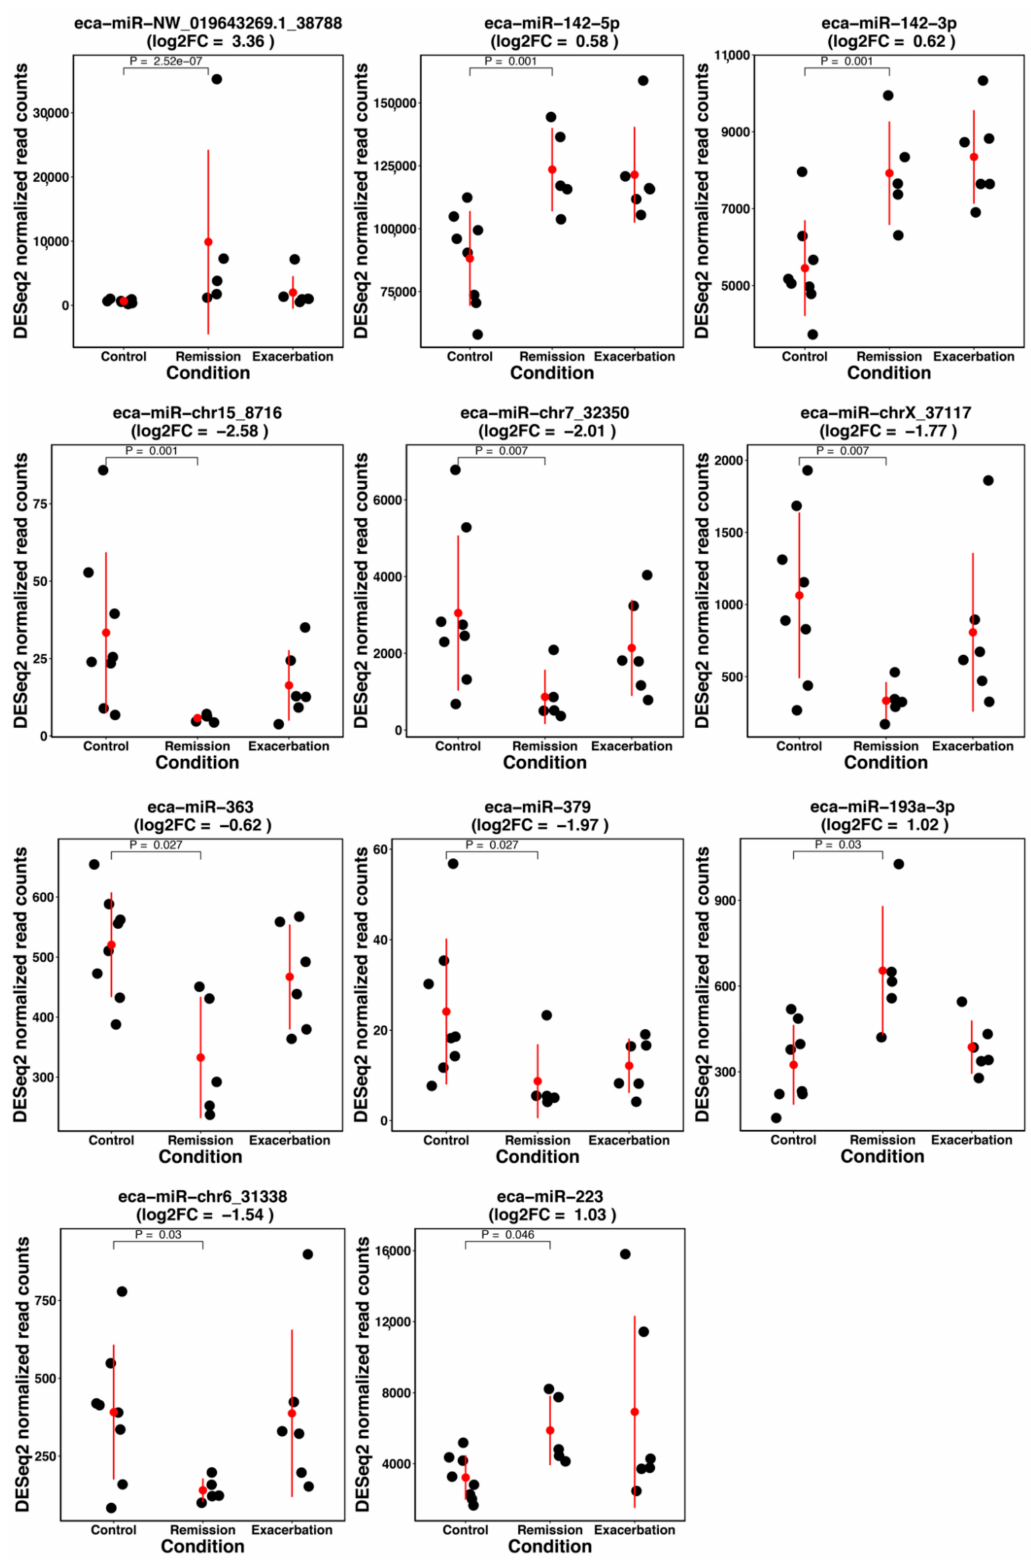
Figure A6. Obtained normalized read counts for all di ff erentially expressed miRNAs for the contrast remission vs. controls. The red dot indicates the mean expression value and the red bars span the range of plus and minus one standard deviation. Adjusted p -values are listed for the contrast of